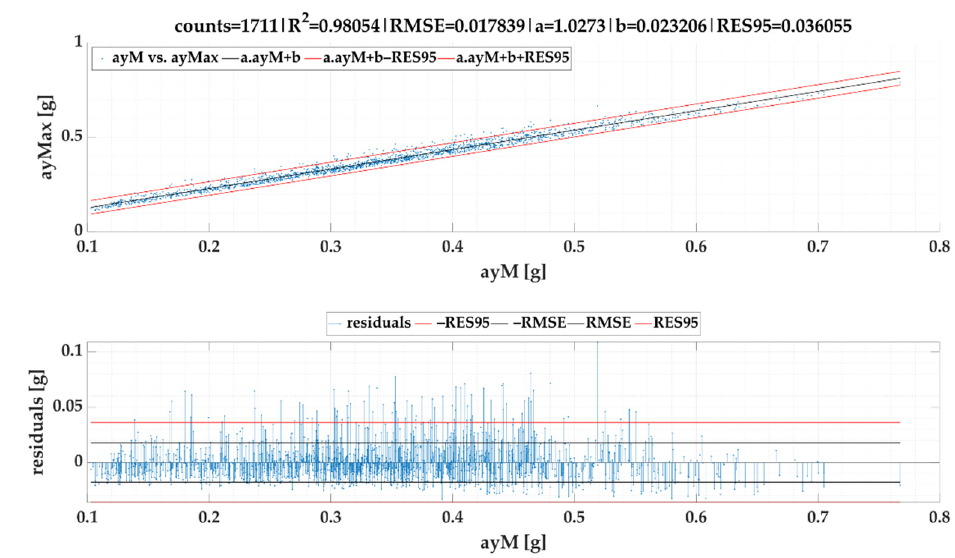
Figure 13. Maximum lateral acceleration 𝑎𝑦𝑀𝑎𝑥 vs. average lateral acceleration 𝑎𝑦𝑀 of events for SEL1.